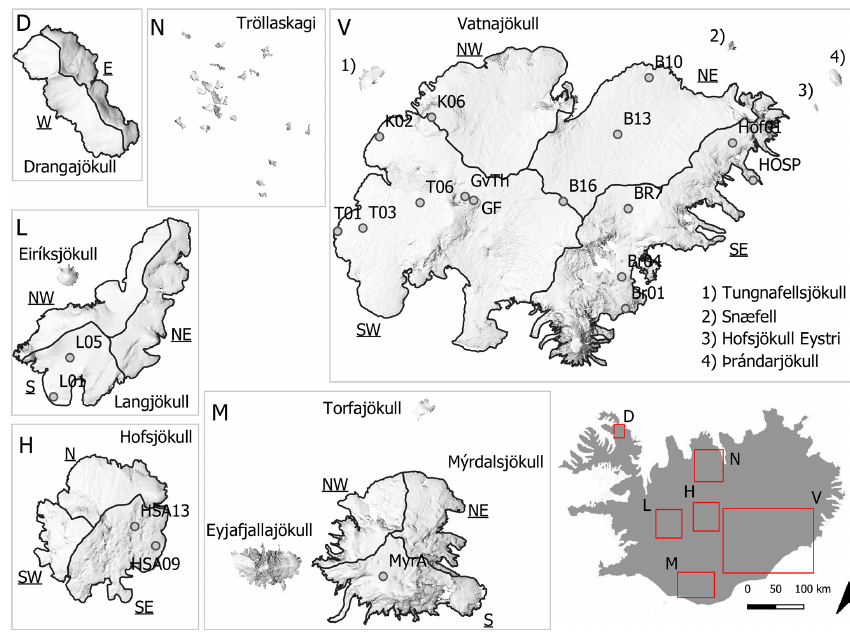
Figure 1. Location map of Icelandic glaciers used in the study. These were glaciers that were at least 2km 2 or eight unmixed MODIS pixels. For the larger glaciers, Vatnajökull, Langjökull, Hofsjökull, Mýrdalsjökull, and Drangajökull, smaller areas are defined to the main ice flow basins of the glaciers for further analysis. These delineated areas are annotated with underlined text (e.g. NW for northwest). In total, 28 areas are processed, including the sub-areas, but small mountain glaciers in northern Iceland were merged into one processing unit. Available glacier automated weather stations are shown with grey dots. Further details of these stations are given in Table 1. A shaded relief representation of a glacier DEM is from Jóhannesson et al. (2013) and catchment delineation from Magnússon et al. (2016), for Drangajökull, Björnsson (1988) and Björnsson et al. (2000) for Hofsjökull and Mýrdalsjökull, and Pálsson et al. (2015, 2020a) for Langjökull and